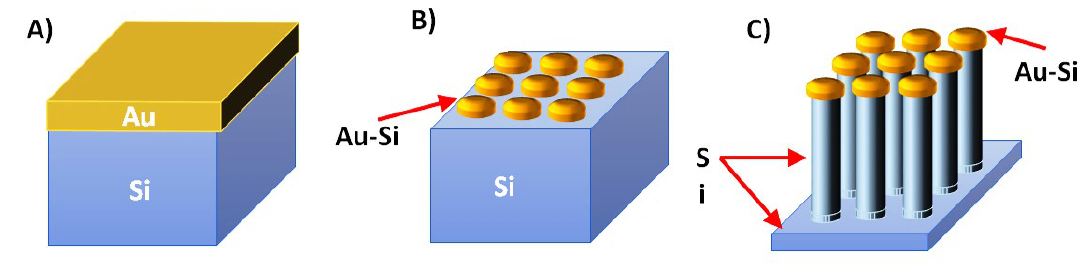
Figure 2. Schematic diagram of Vapor Liquid Solid (VLS) process for growth of SiNW; ( A ) deposition of Au thin film; ( B ) formation of Au-Si to alloy droplet; ( C ) growth of a silicon